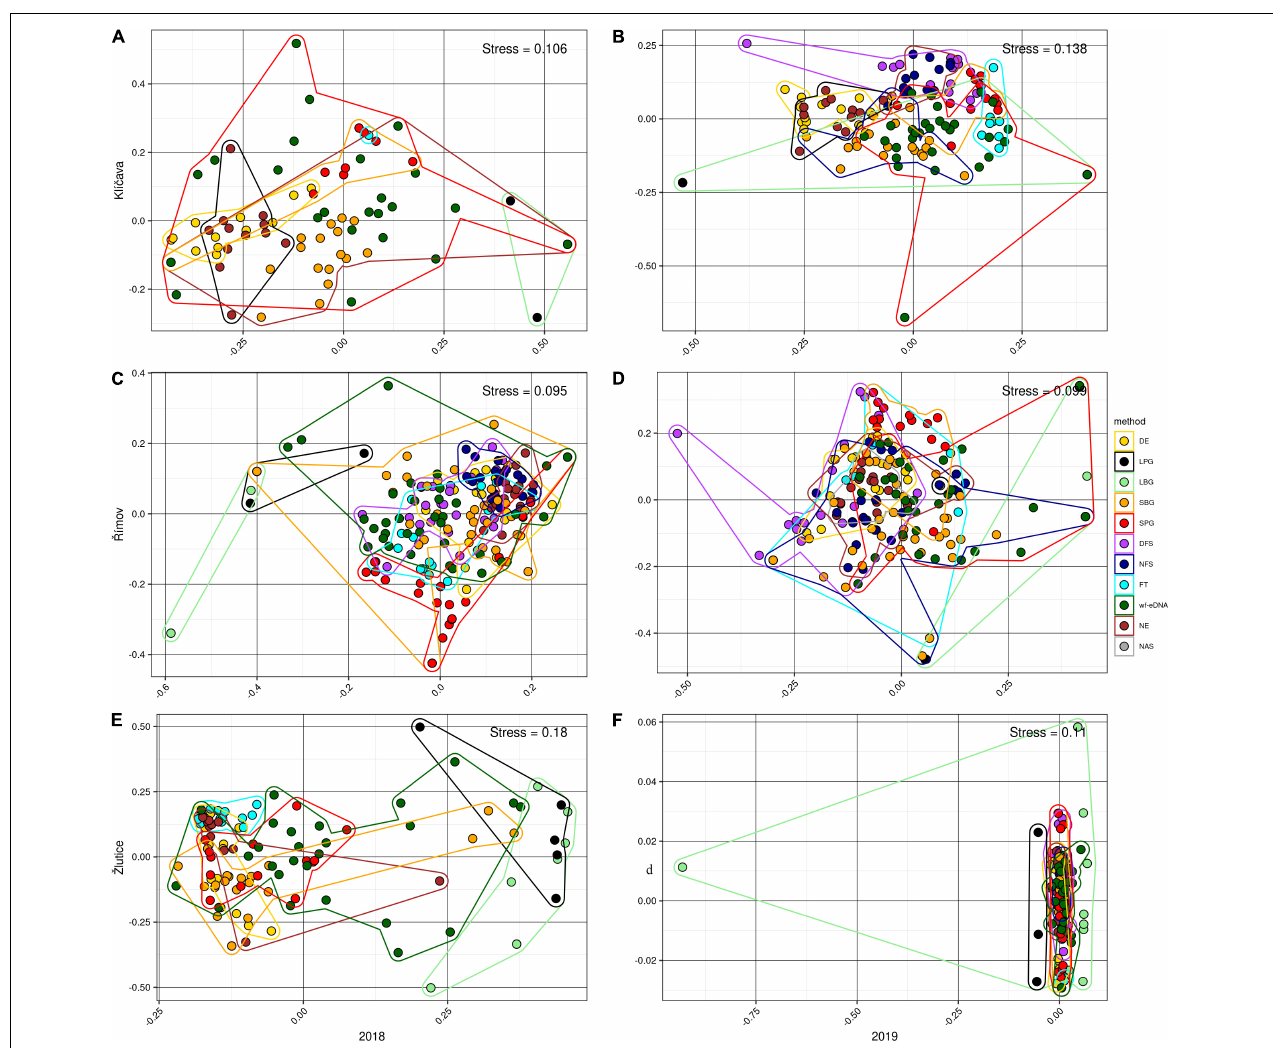
FIGURE 2 | Beta-diversity visualized using non-metric multidimensional scaling (NMDS) based on CPUE data in 2018 (left plots) and 2019 (right plots) with Bray-Curtis dissimilarity distances community compositions for wf-eDNA assay and all traditional sampling methods in Klíˇcava, ˇRímov and Žlutice reservoirs. NMDS plots on rank order using Bray-Curtis distances were used to assess relationship based on intersample variation in estimated fish community composition between sampling methods. Plot ellipses represent the 95% confidence regions for group clusters. Traditional sampling methods are abbreviated as follow: DE = day electrofishing, NE = night electrofishing, SBG = standard benthic gillnets, SPG = standard pelagic gillnets, LBG = large mesh-size benthic gillnets, LPG = large mesh-size pelagic gillnets, NAS = night-time adult seining, DFS = day-time fry seining, NFS= night-time fry seining, FT = fry trawl and wf-eDNA = eDNA from water targeting